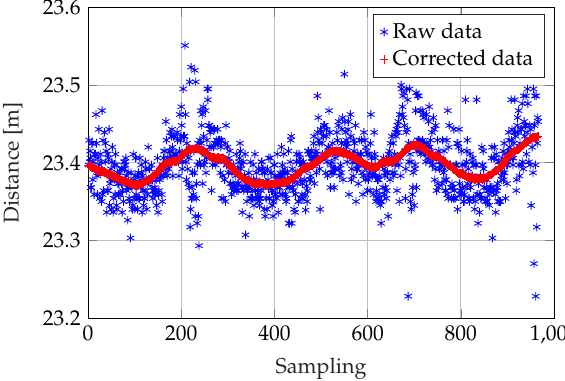
Figure 11. Raw and temperature-corrected measured values in